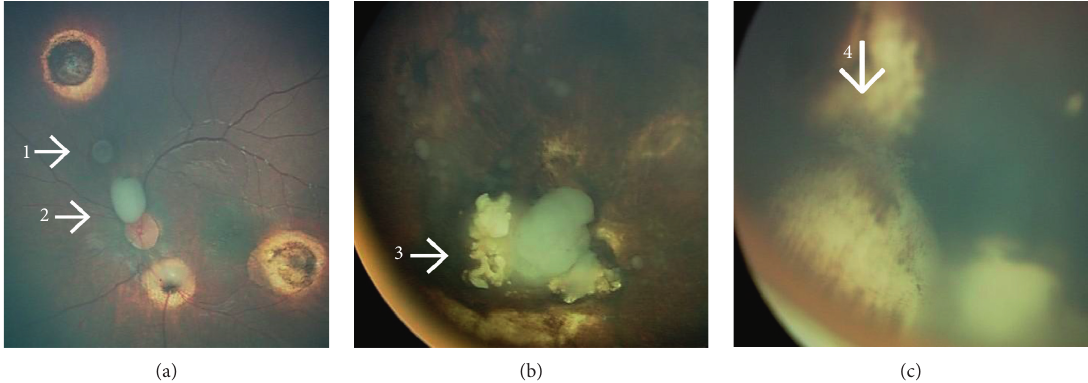
Figure 1: Types of vitreous seeds in retinoblastoma patients. This eye (a) harboured 2 different types of vitreous seeds at the same time: (A-1) sphere vitreous seed (type II) and (A-2) cloud vitreous seed (type III). (b) Cloud vitreous seeds (type III) and (c) dust vitreous seeds (type I).